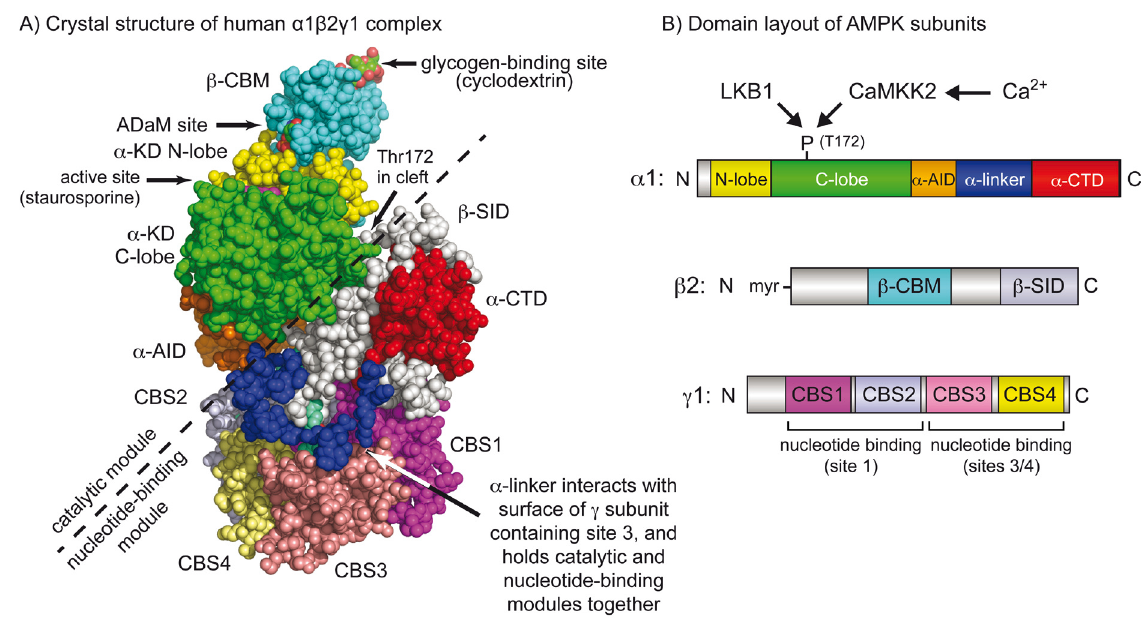
Figure 1. ( A ) Crystal structure based on Protein Data Bank file 4RER 5 and ( B ) domain layout of the human α 1 β 2 γ 1 complex of AMPK. The colour coding of domains in ( A ) and ( B ) is similar. Note that the catalytic module (above and left of the dashed line), comprising the α -KD, β -CBM, and α -AID, is a rather independent entity from the nucleotide-binding module (below and right of the dashed line), comprising the γ subunit, α -CTD, and β -SID. The α -linker is the principal “hinge” that connects these two modules. In this active conformation, the two modules are close together because the close interaction of the α -linker with AMP bound in site 3 pulls them together. However, when ATP rather than AMP occupies site 3, the α -linker is thought to dissociate from the γ subunit, allowing the two modules to move apart. This is thought to allow the α -AID to rotate back into its inhibitory position behind the α -KD 5 while also exposing phospho-Thr172 to protein phosphatases. In the active conformation in the picture, phospho-Thr172 is located around the back of the molecule in the cleft between the two modules. α -AID, alpha subunit auto-inhibitory domain; α -CTD, alpha C-terminal domain; α -KD, alpha subunit kinase domain; β -CBM, beta carbohydrate-binding module; β -SID, beta subunit interaction domain; AMPK, AMP-activated protein kinase; CBS, cystathionine-beta-